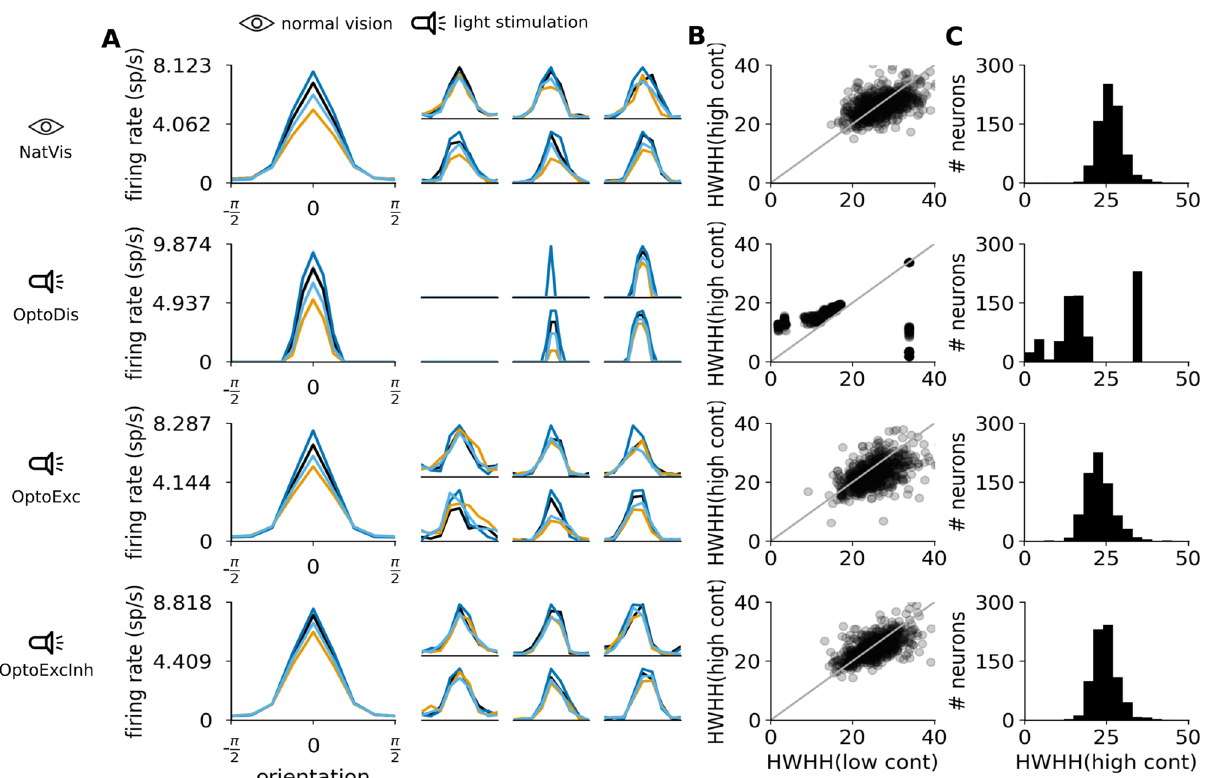
Figure 5. Orientation tuning of model neurons in the 4 experimental conditions. From top to bottom NatVis, OptoDis, OptoExc, and OptoExcInh conditions. ( A ) Mean orientation tuning curves across all recorded neurons (larger plot) and examples of individual tuning curves in 6 randomly selected neurons (smaller plots). ( B ) Scatter plot of half-height at half-width (HWHH) of orientation tuning curves at low (abscissa) versus high (ordinate) contrast. ( C ) Distribution of HWHH at high contrast